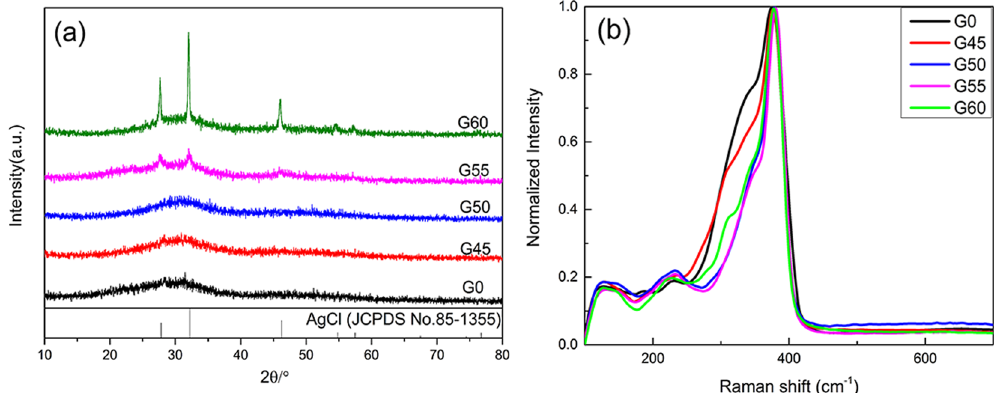
Figure 1. XRD patterns ( a ) and normalized Raman spectra ( b ) of all